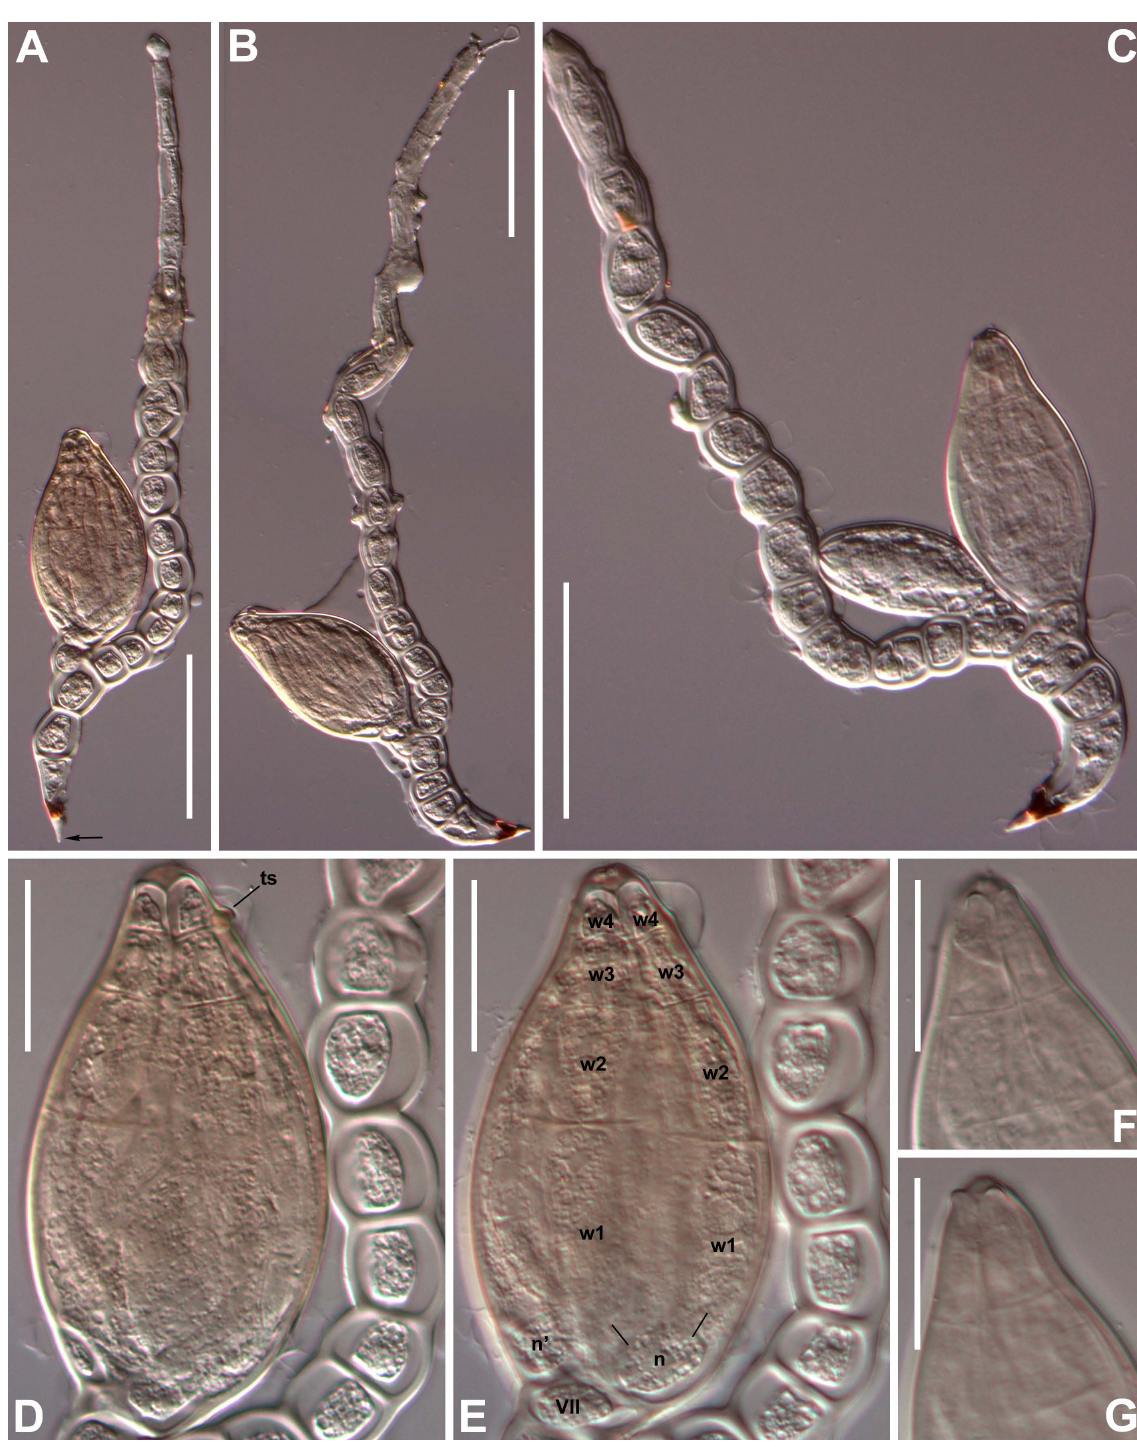
Fig. 63. Tanmaurkiella huggertii Santam. gen. et sp. nov. A – B . Mature thalli. In A, the pointed hyaline beak at the base of the foot is labelled (arrow). C . Mature thallus with a second young perithecium. D – E . Perithecium in detail, at two focus levels, near (D) and far (E), to show perithecial wall cells (w developed from cell “n”, cells n’, VII and trichogyne scar (ts). F – G . Perithecial tip in detail at near (F) and far (G) focus to show the four preapical protuberances. Scale bars: A–C = 50 µm; D–G = 20 µm. Photographs from slide ZMUC C-F-122720